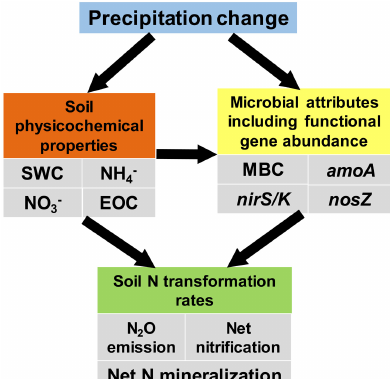
Figure 1. A conceptual model illustrating the effects of physico- chemical properties and functional microorganisms on N transfor- mation rates. Soil water content (SWC), ammonium (NH + ) and extractable organic carbon (EOC) concentrations trate (NO − 3 were included in the group of soil physicochemical property. Mi- crobial biomass carbon (MBC) and nitrifying ( amoA ) and denitri- fying ( nirK , nirS and nosZ ) gene abundance were included in the microbial attributes group. The solid lines with arrows indicate the direction of the